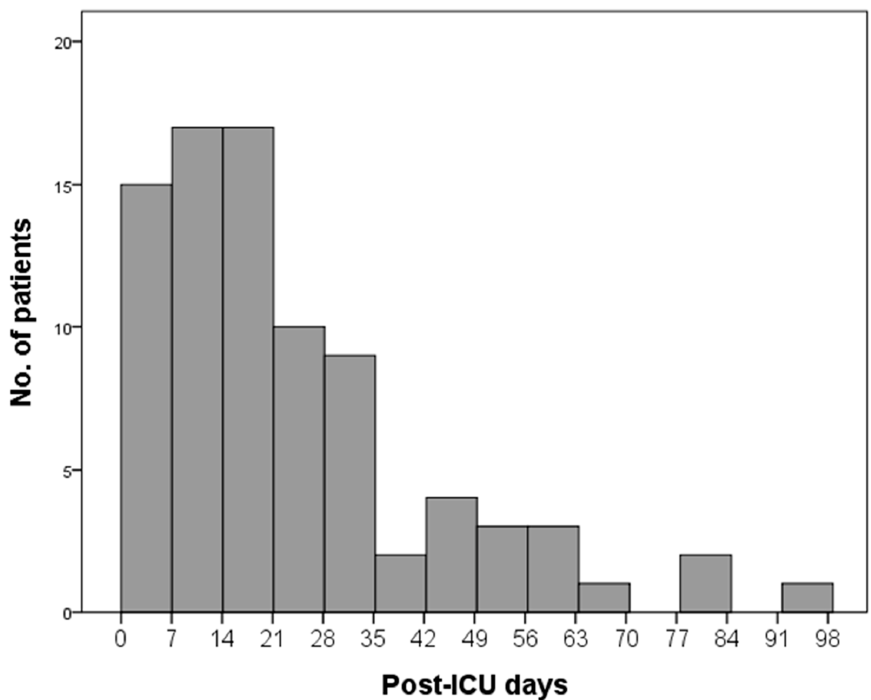
Figure 1. Distribution of deaths according to time post-ICU admission. ICU, intensive care unit. 128 During the ICU stay, new-onset sepsis developed in 99 (28%) patients (Table 2). Cardiovascular 129 events ( n = 8, 2.3%) were uncommonly observed in the study participants. Of note, new-onset ICU 130 sepsis was associated with a worse outcome in septic patients. Approximately one third (31/89, 35%) 131 of non-survivors succumbed to the index sepsis; however, more patients (34/89, 38%) died of the 132 subsequent sepsis (Table 3). 133